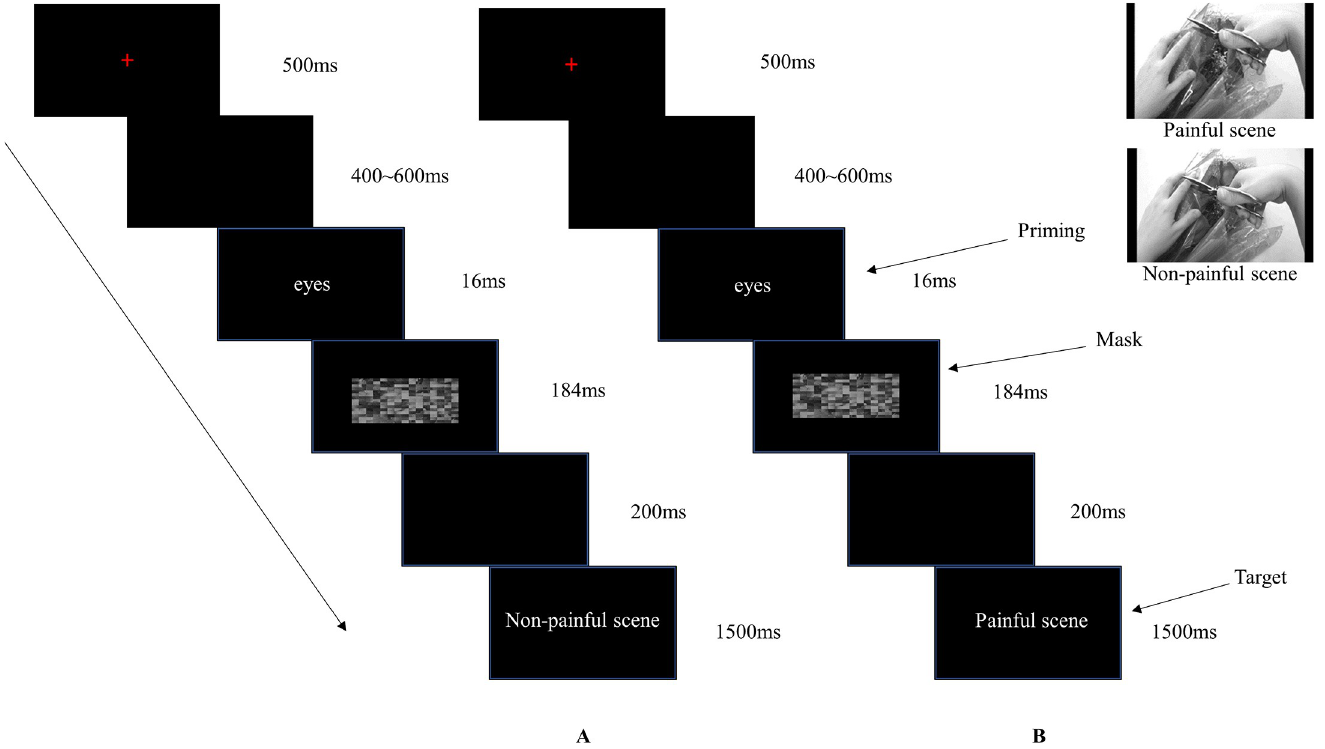
Fig 1. The procedure of the effect of subliminal emotional information from eyes on empathy for pain. Panel A showed the target illustrated a non-painful scene. Panel B showed the target illustrated a painful scene. Participants were asked to judge whether the target was painful or not.